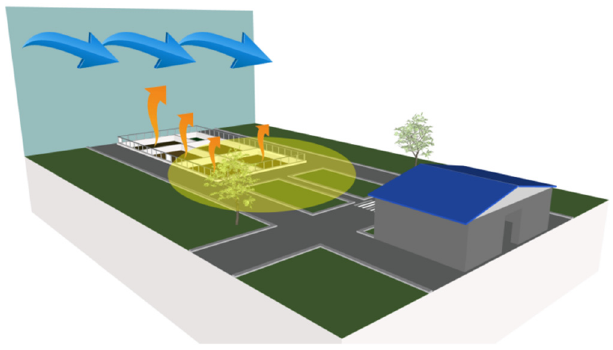
Figure 11. Modified model of building layout near automobile sewage pool.